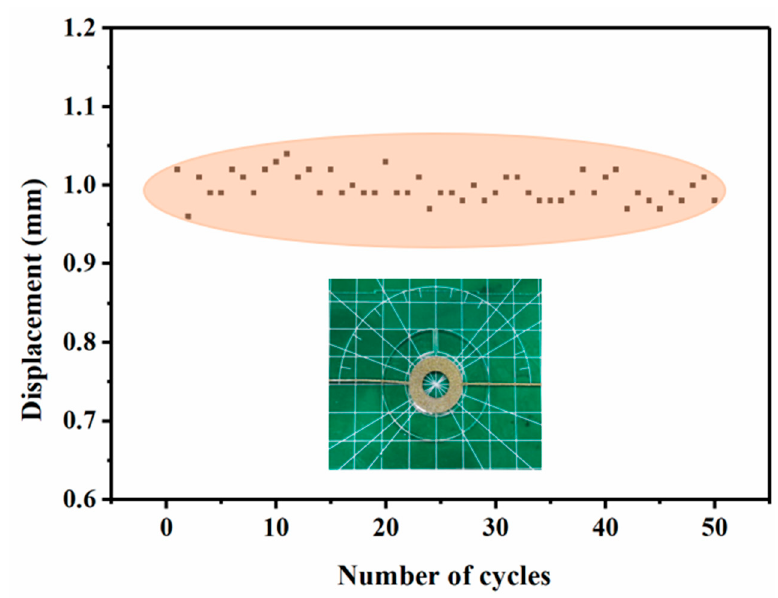
Figure 11. The relationship between the number of cycles and the stable displacement under the same voltage (12 kV, 20 Hz).